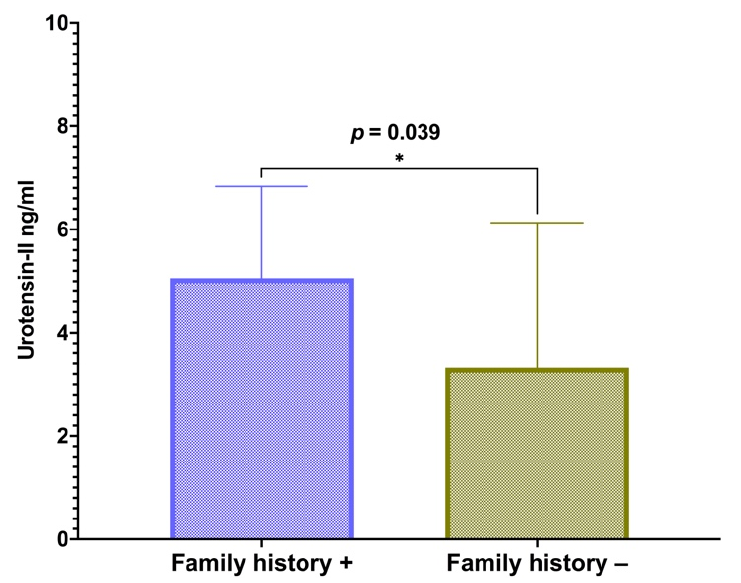
Figure 3. Association of urotensin with a positive family history of high blood pressure in obese children and adolescents. * Significance level ( p ) was set to <0.05.